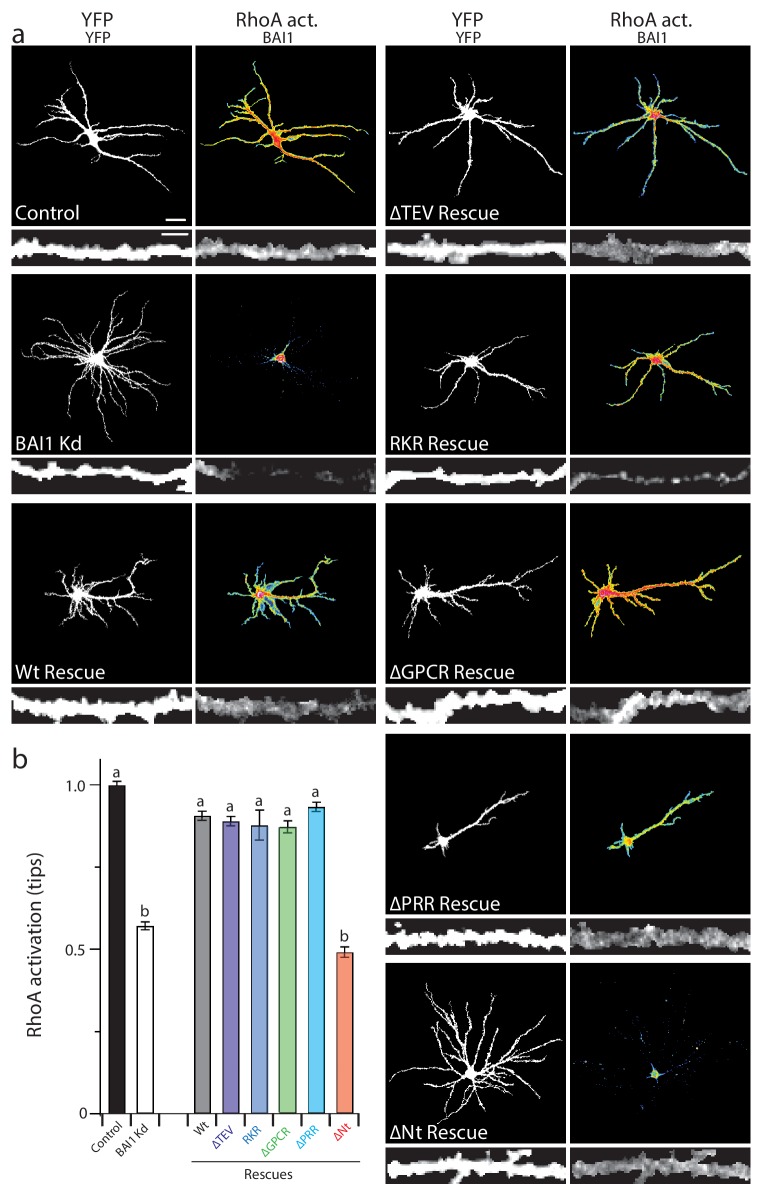
Proper RhoA activation is required for rescue of the BAI1 Kd-mediated dendrite overgrowth.(a) Representative images of hippocampal neurons expressing the RhoA activation reporter RhoA-FLARE, along with control vector (control), shRNA against Adgrb1 (BAI1 Kd), or shRNA against BAI1 and RNAi-resistant BAI1 (Wt rescue) or the indicated RNAi-resistant mutants (see Figure 6). The 4-panel cluster for each condition consists of an image of the complete somatodendritic domain obtained by direct excitation of the acceptor (YFP images, upper left; bar is 20 µm), a map of RhoA activation color-coded according the scale in Figure 3 (RhoA Act., upper right), and digitally magnified stretches of dendrite showing morphology obtained by direct excitation of the acceptor (YFP, lower left; bar is 5 µm), and BAI1 immunostaining (BAI1, lower right). Images are masked to remove axons and dendrites from other neurons. (b) Summary data of RhoA activation at dendritic tips. Total number of dendrite tips: 670 for controls, 495 for BAI1 Kd, 630 for wt rescues, 640 for ∆TEV rescues, 60 for RKR rescues, 40 for ∆GPCR rescues, 635 for ∆PRR rescues, and 55 for ∆Nterm. rescues (N = 5). Data are represented ± s.e.m. (aP >0.05 within group a, but p<0.05 vs. group b; bP >0.05 within group b, but p<0.05 vs. group a.) Detailed statistics are found in Figure 6—source data 1.10.7554/eLife.47566.047Figure 6—source data 1.Statistical summary for Figure 6: ANOVA and key Tukey post-hoc tests and N and n values for (Figure 6b).10.7554/eLife.47566.046Figure 6—source data 2.Individual measurements of RhoA activation at dendrite tips in molecular replacement experiments (Figure 6b).